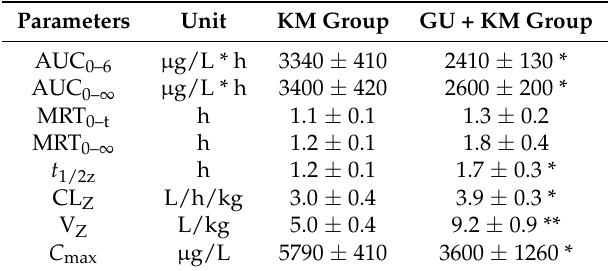
Table 5. Pharmacokinetics parameters of KM (10 mg/kg, intravenous administration) in rat that received or did not receive GU decoctions.